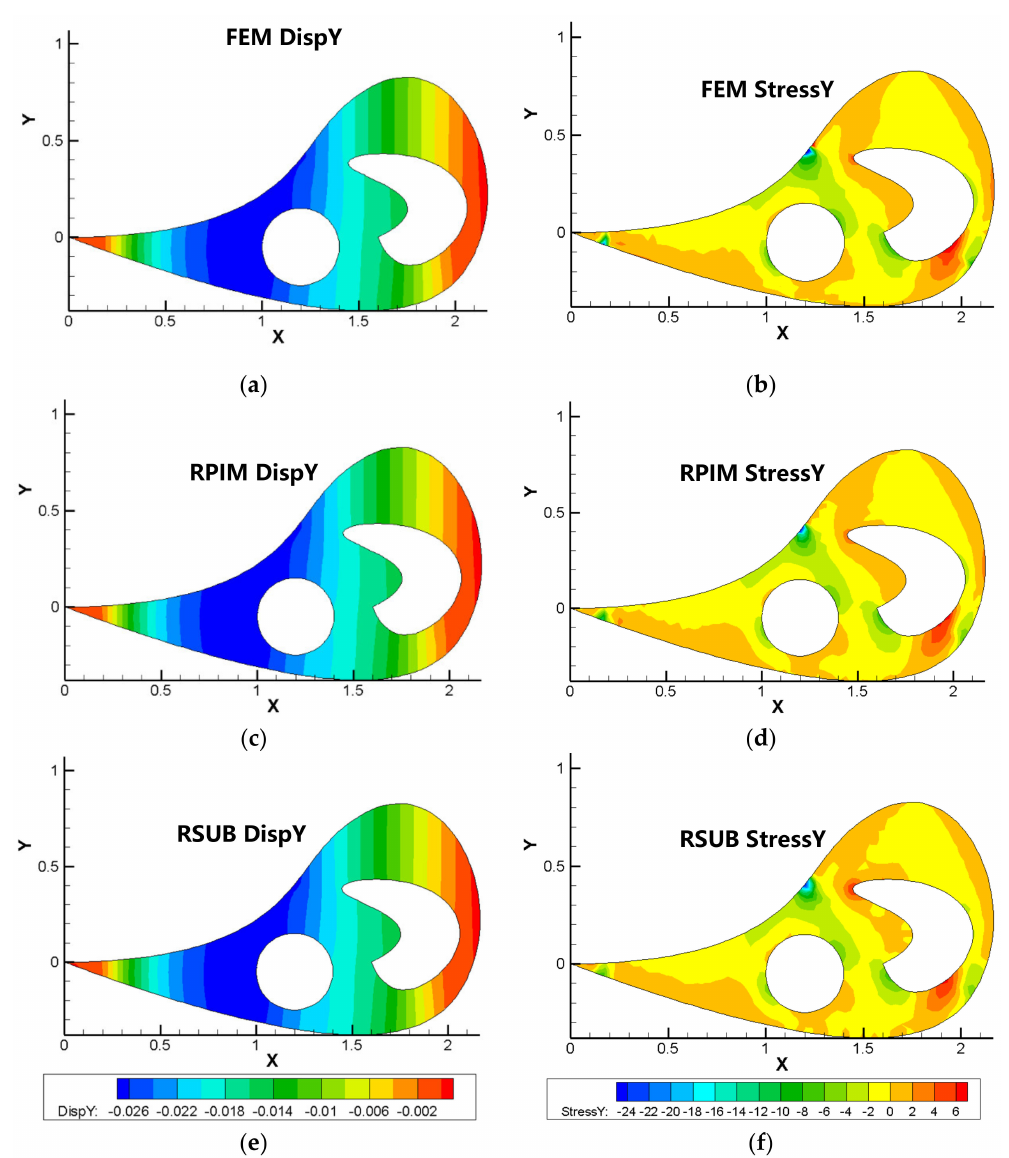
Figure 17. Displacement in y-direction of di ff erent methods: ( a ) FEM; ( c ) RPIM; ( e ) RSUB. Stress in y-direction of di ff erent methods: ( b ) FEM; ( d ) RPIM; ( f )